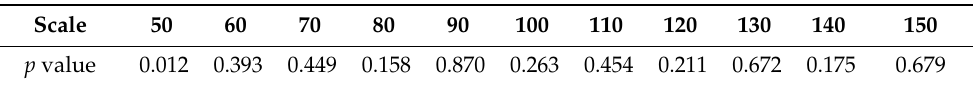
Table 2. Di ff erences between classification accuracies with or without feature selection based on Welch’s t -test.